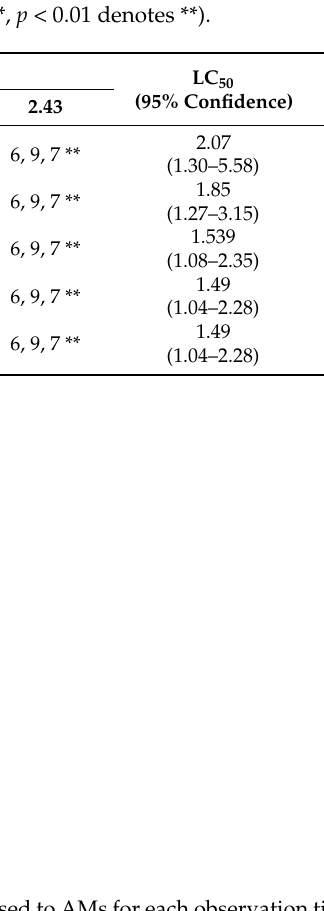
Table 3. Lethal e ff ects of AMs from A. carterae on the early development of zebra fi sh embryos. The zebra fi sh embryos were treated with 0.03% MeOH (control), and 0.081, 0.81, 1.62, 2.03, and 2.43 µg/mL of AMs at di ff erent times of exposure (12, 24, 48, 72, and 96 h). Descriptive data represent the number of dead embryos as a percentage of three independent experiments (n = 30 per group, one- way ANOVA, Turkey’s HSD at p < 0.05 denotes *, p < 0.01 denotes **).